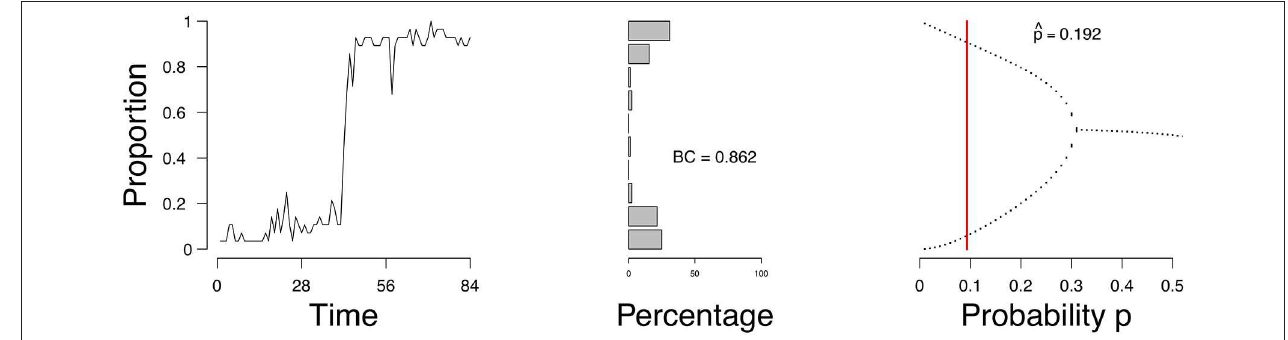
FIGURE 9 | Proportion of active symptoms (Left) and bifurcation diagram (Right) of one participant from the Groningen data. BC = bimodality coefficient. Red line indicates the estimate ˆ p .